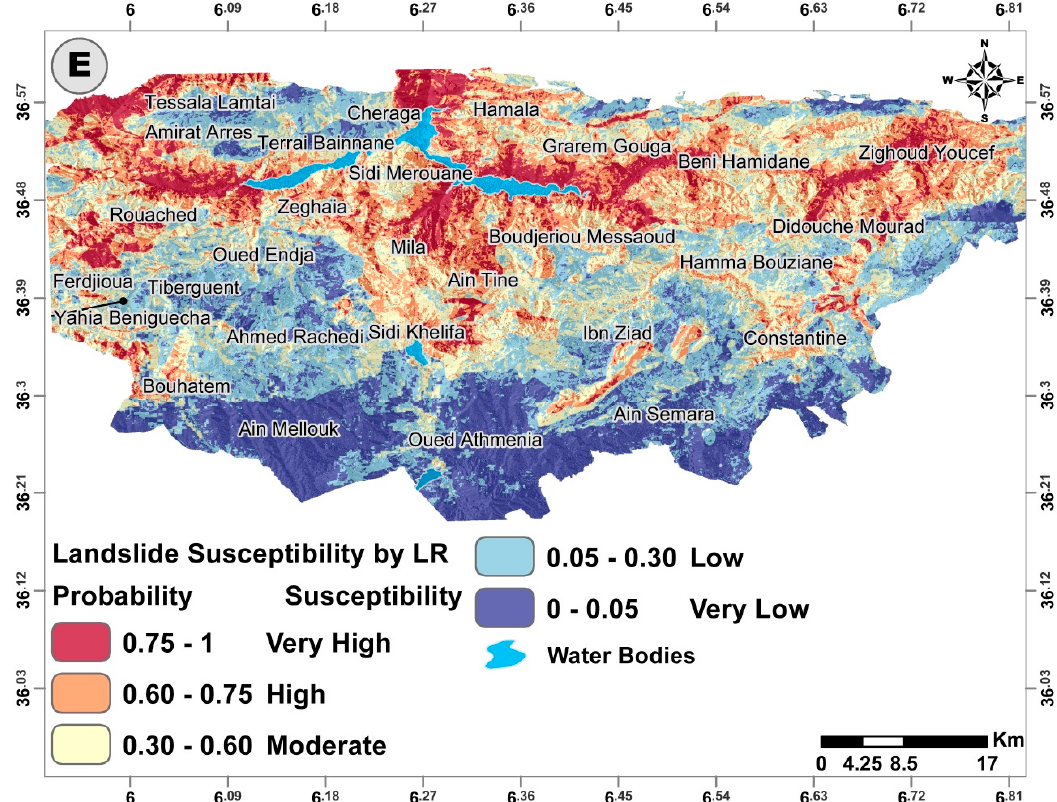
Figure 10. The generated landslide susceptibility maps using: ( A ) GBM, ( B ) RF, ( C ) NNET ( D ) SVM; and ( E ) LR.